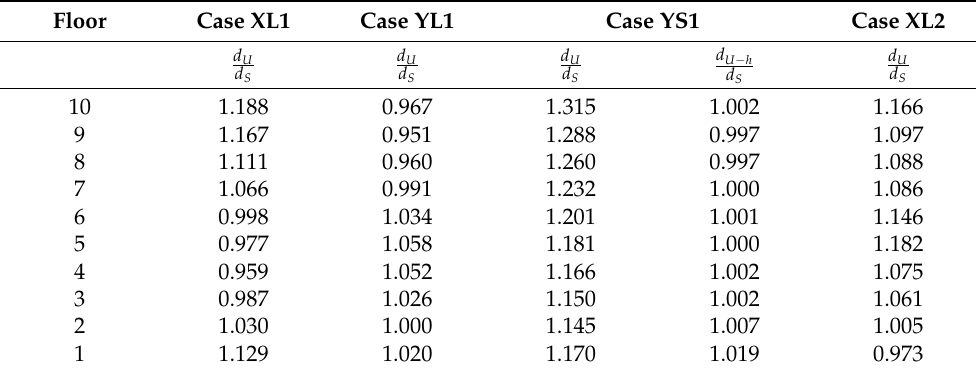
Table 4. The ratios of the maximum inter-story displacements (unit: